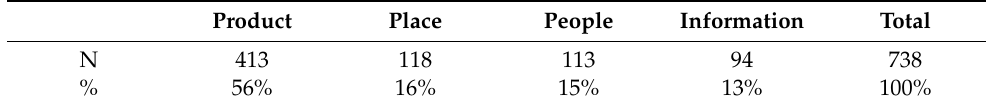
Table 4. Totals of categories represented on bakeries’